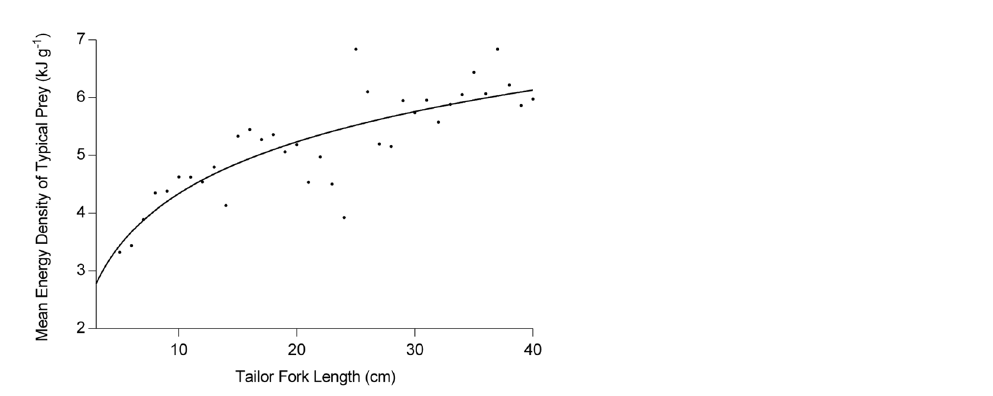
Figure 3. The mean energy density ( E ) of prey typically consumed by tailor ( E , n = 1437 tailor stomach contents) throughout ontogeny (black dots represent mean values of 1 cm tailor size classes). The solid black line is the fitted curve described by equation (6).